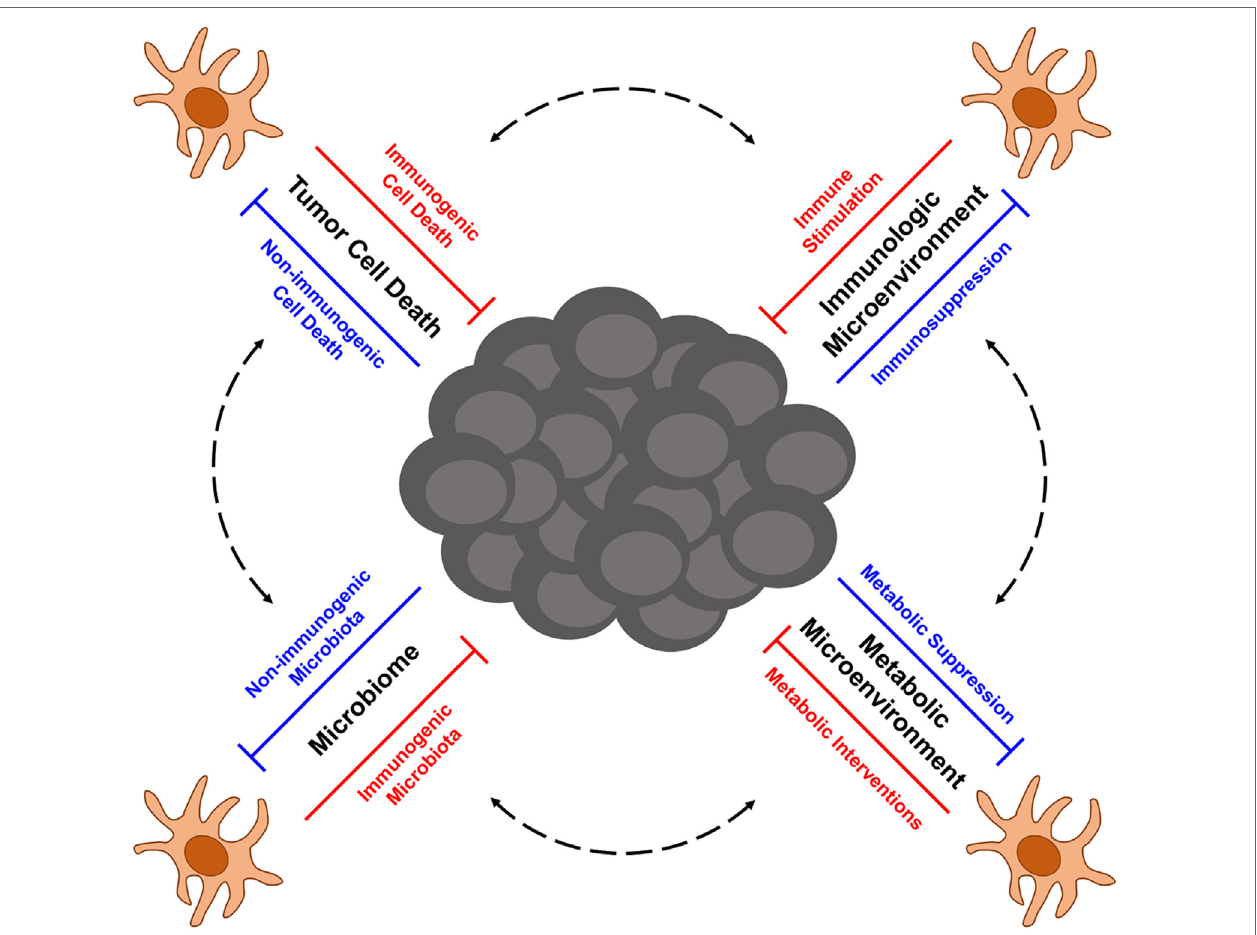
FiGURe 4 | Multifactorial influences on the function of melanoma-associated dendritic cells (DC). A variety of complex factors contribute to the immunoregulation of DC in the context of melanoma. Elements that control the immunogenicity of tumor cell death, the balance of immunostimulatory versus immunosuppressive signals in the tumor microenvironment, metabolic influences on DC function, and the microbiome all interact to dictate the immune stimulatory capacity of melanoma- associated DC. Mechanistic insights into each of these layers of DC immune regulation provide opportunities for therapeutic interventions to enhance the immunogenicity and antitumor function of melanoma-associated DC as described in more detail in the